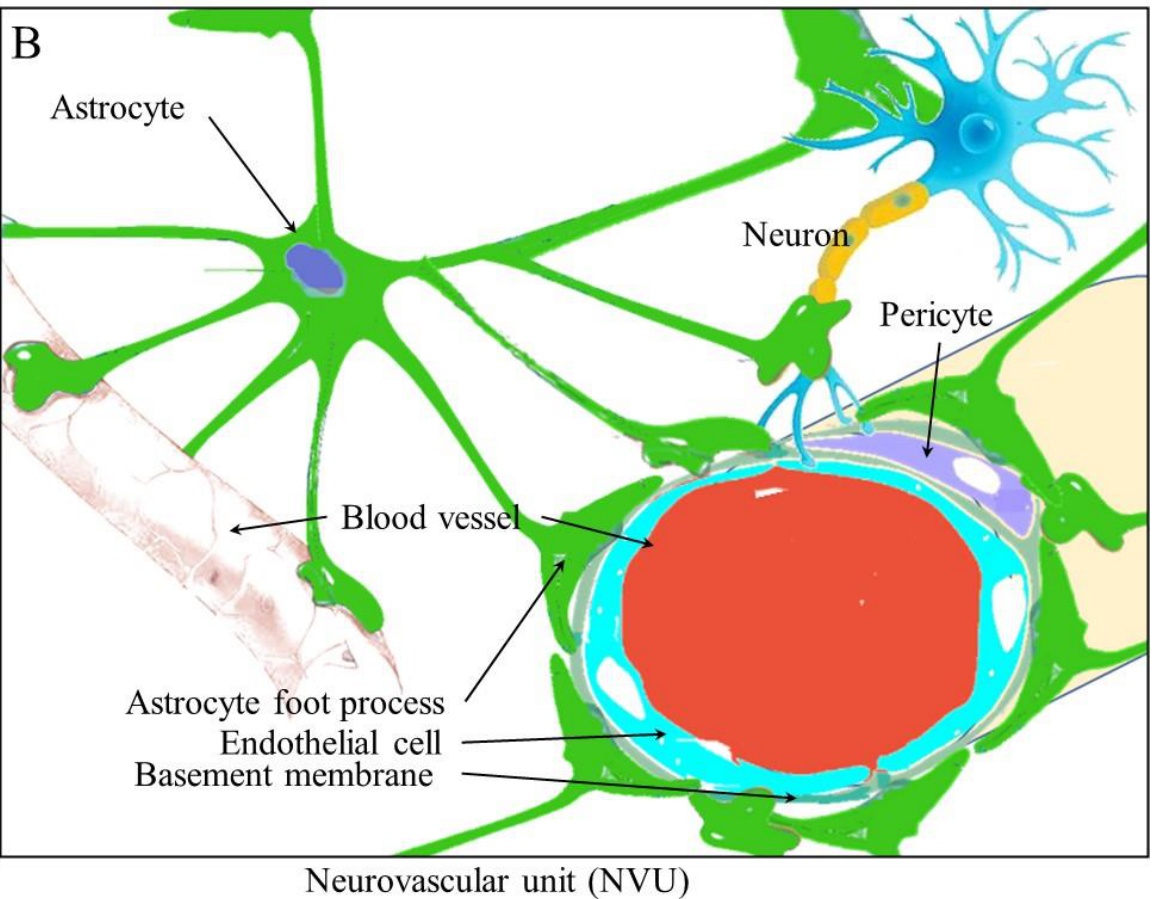
Figure 1. The physiological relationship between the vascular and nervous systems. ( A ) The vascular and neural systems mirror each other in the body as they both are required to service the entire body ( B ). The structure of the neurovascular unit in the brain and the blood brain barrier.